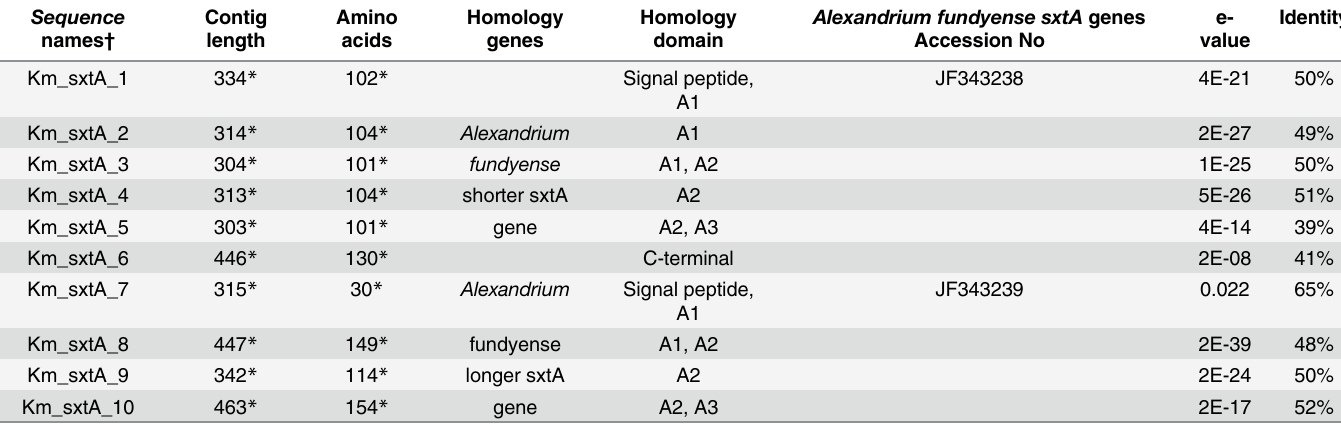
Table 6. Summary of sxtA genes in Karenia mikimotoi .